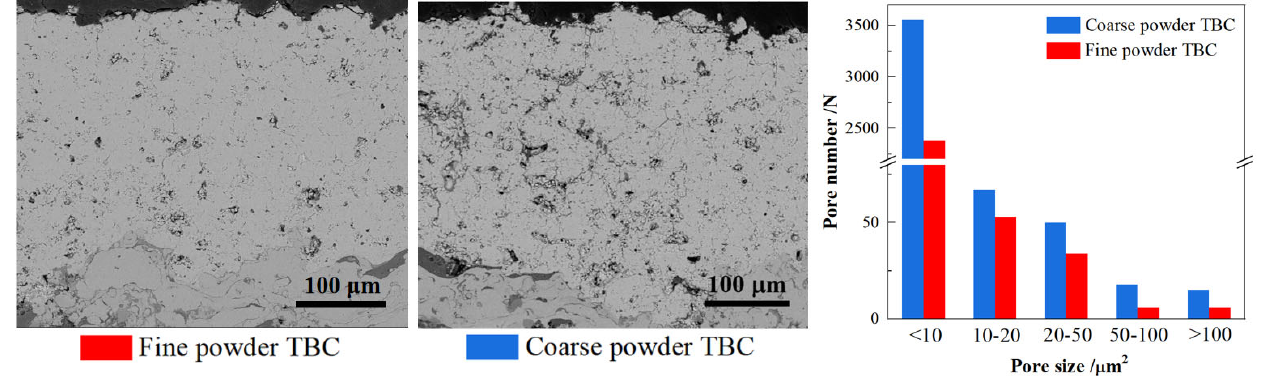
Figure 3. Typical microstructure and pore size distribution of the as-sprayed coatings prepared by the fine and coarse YSZ powder.